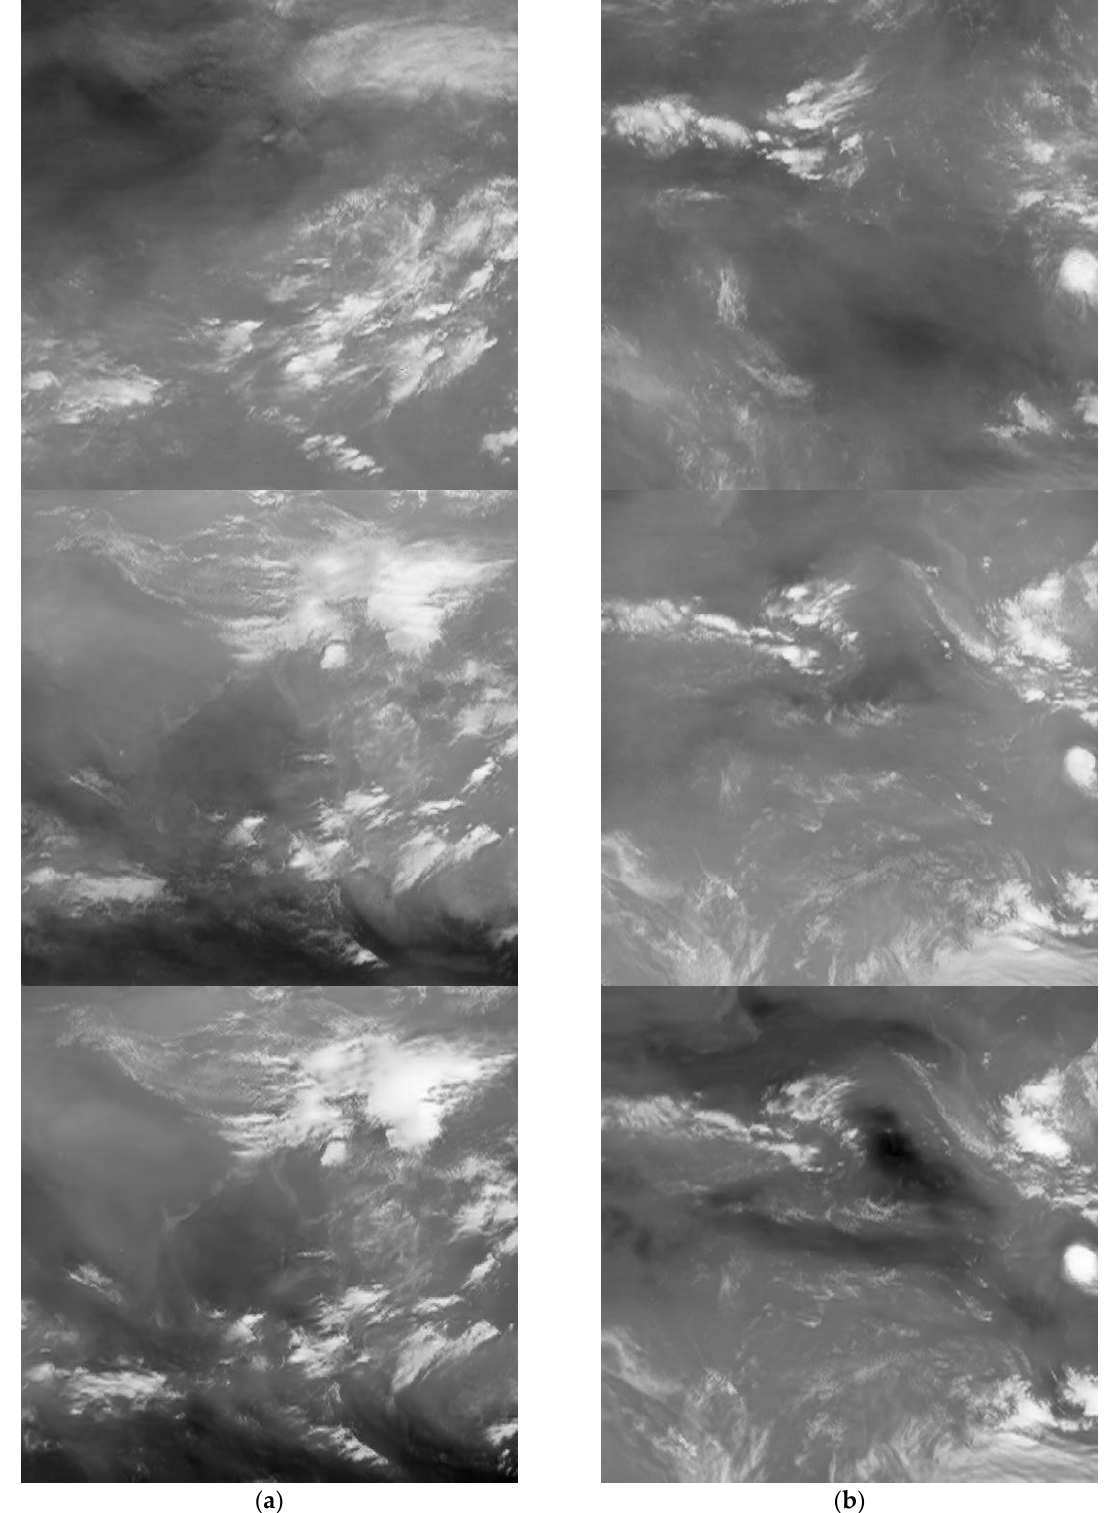
Figure 5. Visual comparison of different models for translation from visible spectrum domain to infrared spectrum domain. Subfigures ( a ) and subfigures ( b ) are two independent test cases.